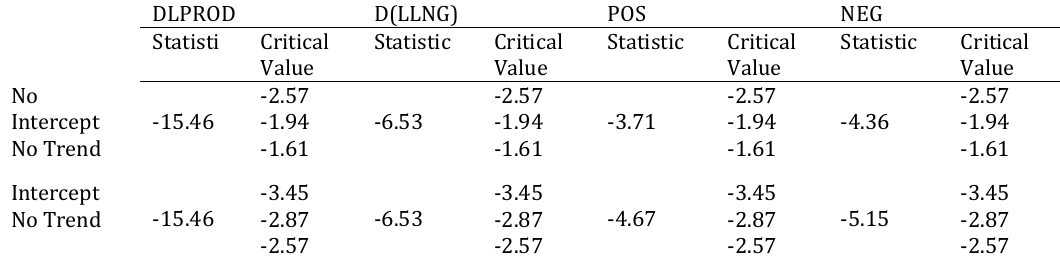
Table A4: The ADF test Results/ Hodrick-Prescott